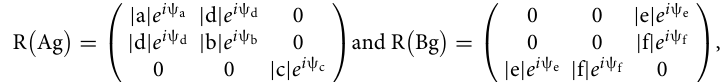
where ψ a , ψ b , ψ c , ψ d , ψ e , ψ f are the phases of Raman tensor elements, and |a|, |b|, |c|, |d|, |e|, |f| are amplitudes of Raman tensor elements. The calculated Raman intensities for the A g and the B g modes in both polarization configurations are shown below.